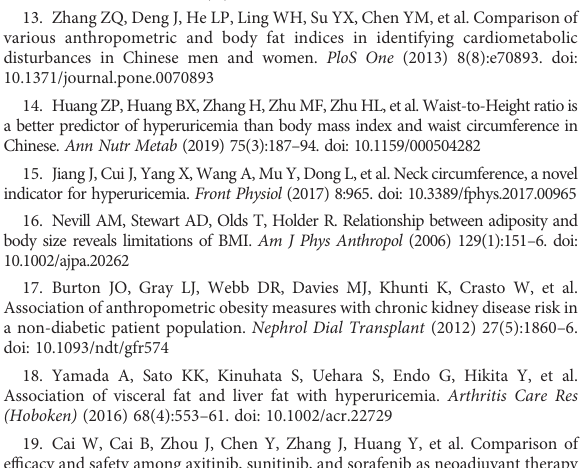
SUPPLEMENTARY TABLE 2 Odds ratios and 95% CIs for hyperuricemia according to BMI as continuous variables and